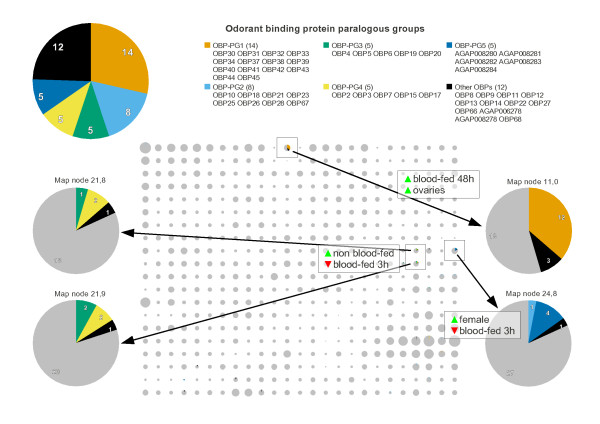
Odorant binding proteins (OBPs) are found in several distinct regions of the expression map, which generally correspond to paralogous groups. The OBP paralogous groups (OBP-PGs) are defined (top). OBPs are shown as coloured pie sections on the expression map (centre) with regions of interest are outlined and annotated in terms of two major expression characteristics. The pie charts of four map nodes dominated by OBPs are shown at greater magnification (bottom left and right).